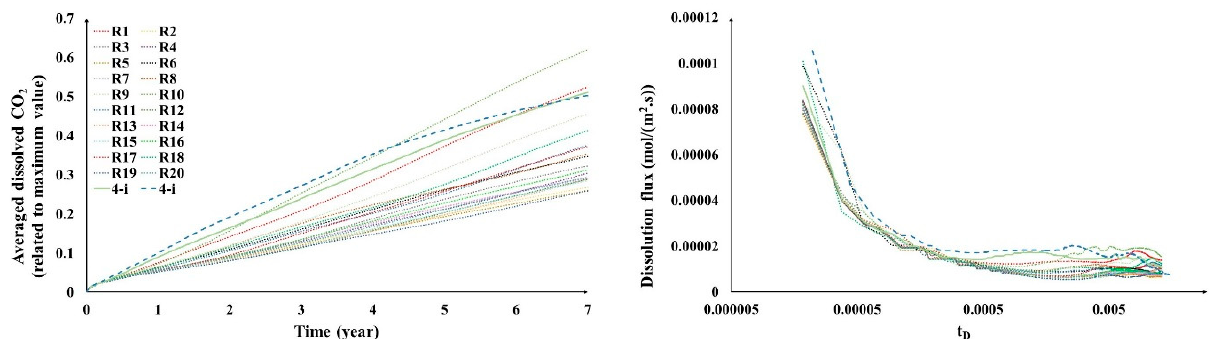
Figure 10. The heterogeneous realizations (dotted lines), homogeneous with considering cross-diffusion (solid line), and homogeneous without considering cross-diffusion (dashed line) averaged dissolved CO 2 and dissolution flux for case 4-i. Legends for left- and right-hand subplots are same.